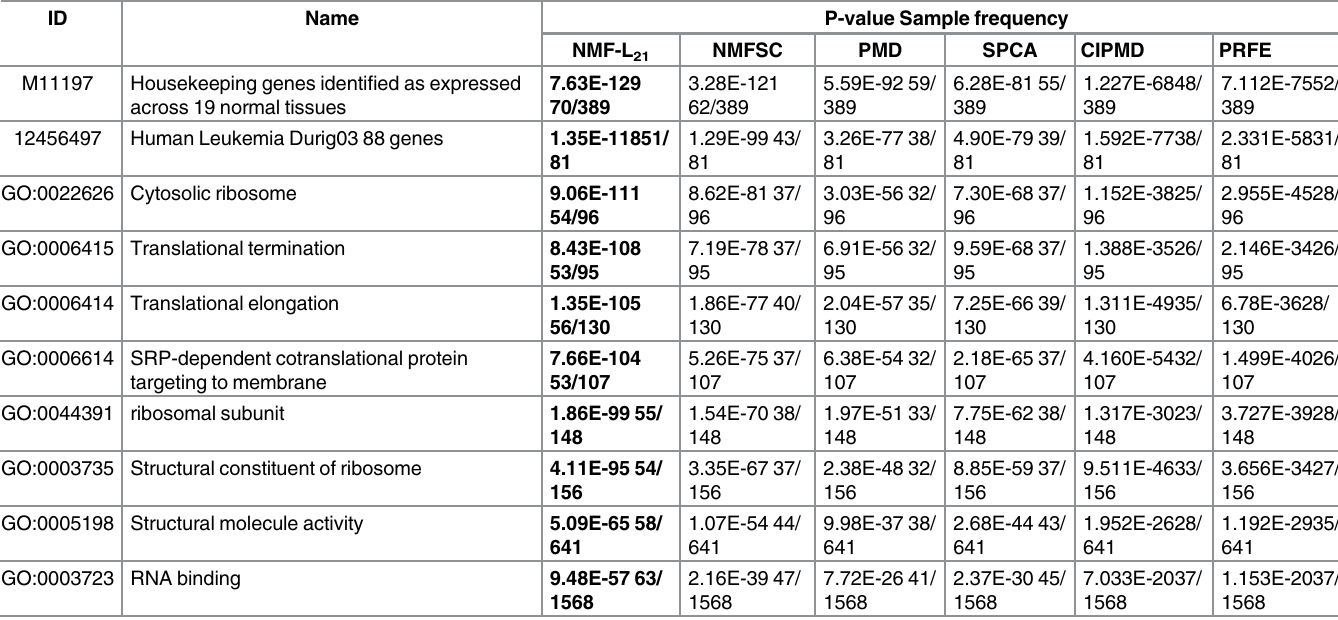
Table 6. P-value Terms for the Medulloblastoma Dataset.